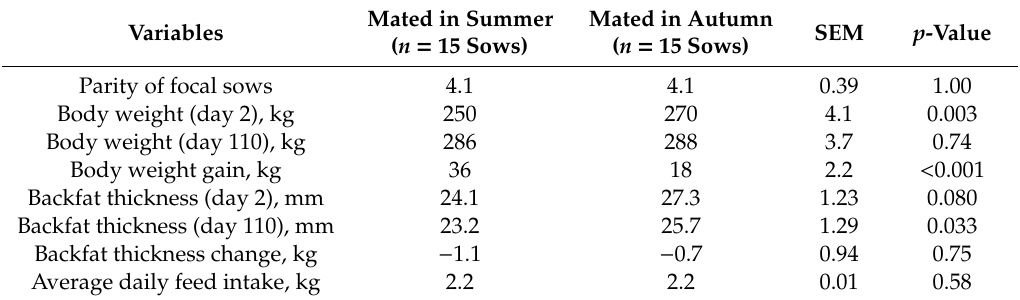
Table 1. Gestational feed intake and body weight change of gestating sows mated in summer vs.